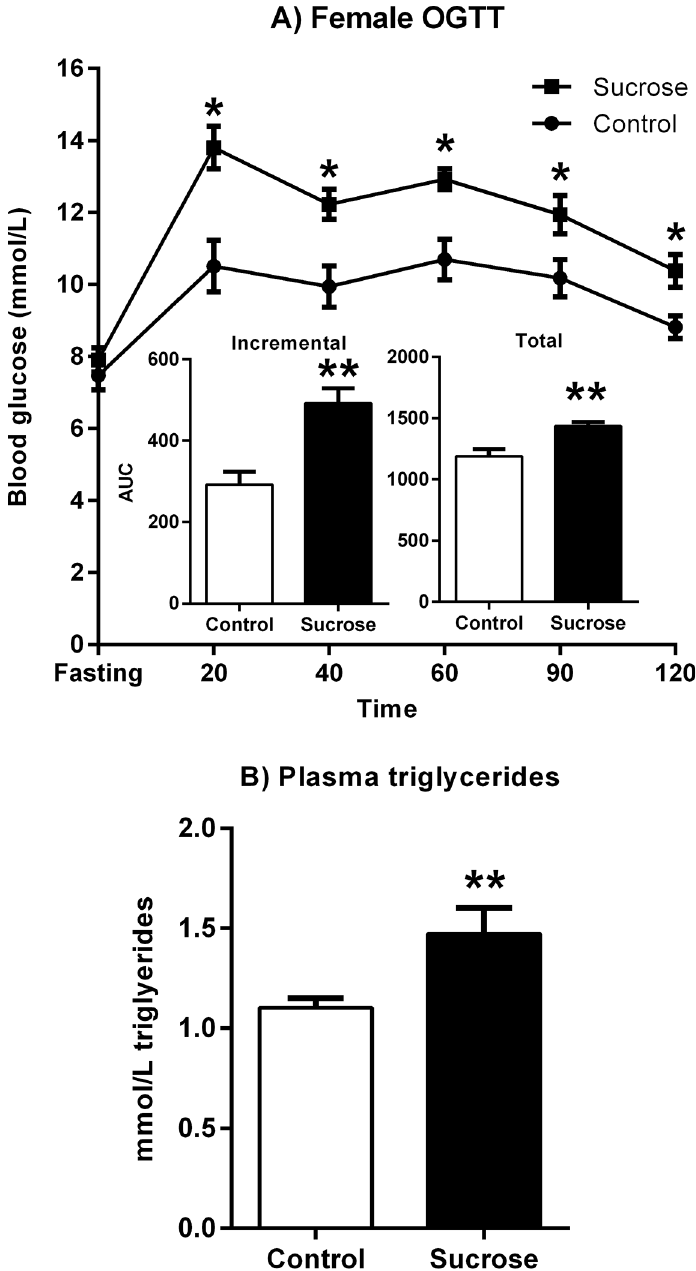
Fig 3. Maternal metabolic measures after sucrose feeding. Sucrose-fed female rats were glucose intolerant after 28 days of access to 10% sucrose solution, as indicated by higher incremental and total AUC during an OGTT (Panel A). Fasting blood triglycerides were significantly higher in the Sucrose group (Panel B). Data are group means ± SEM. * p < .05, ** p < .01 and 11.04 ± .86 (SEM) for the Sucrose group; this difference was not statistically significant ( t < 1). Eleven out of the 12 females in the Sucrose group and 11 of the 12 females in the Control group delivered litters (one rat from each group miscarried). Two Control females failed to